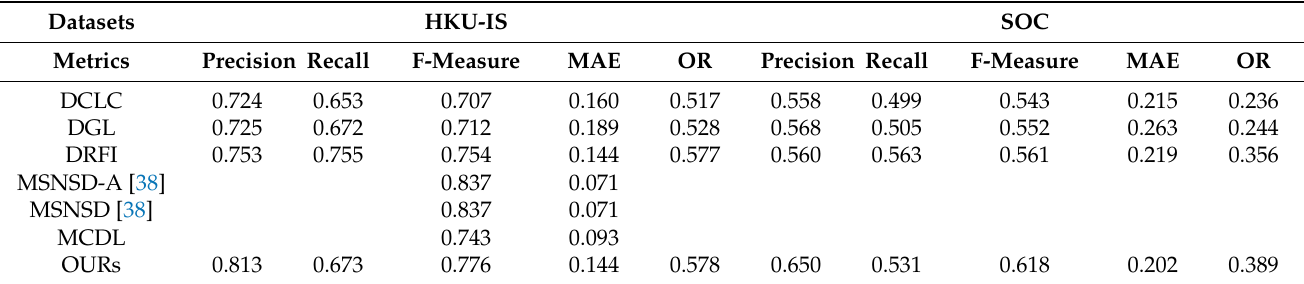
Table 5. Results of precision, recall, F-Measure, MAE and OR on HKU-IS and SOC